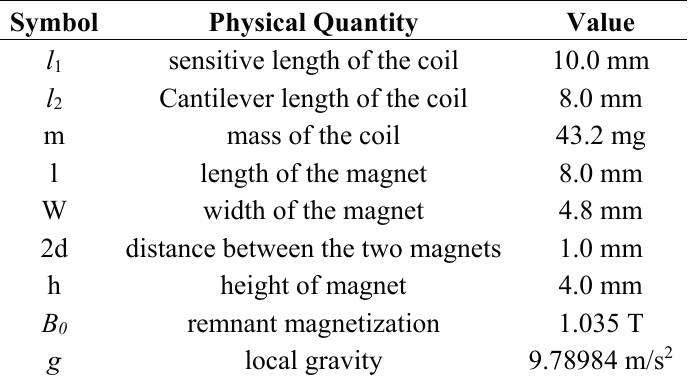
Table 1. The parameters of the accelerometer.